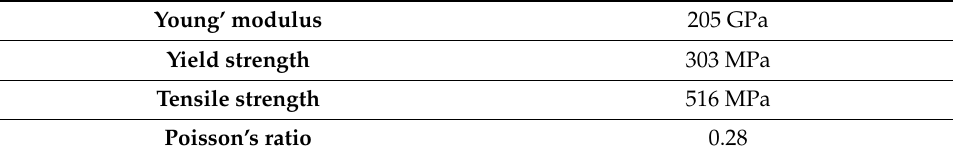
Table 2. Material properties of steel liner (34CrMo4). Young’ modulus 205 GPa Yield strength 303 MPa Tensile strength 516 MPa Poisson’s ratio